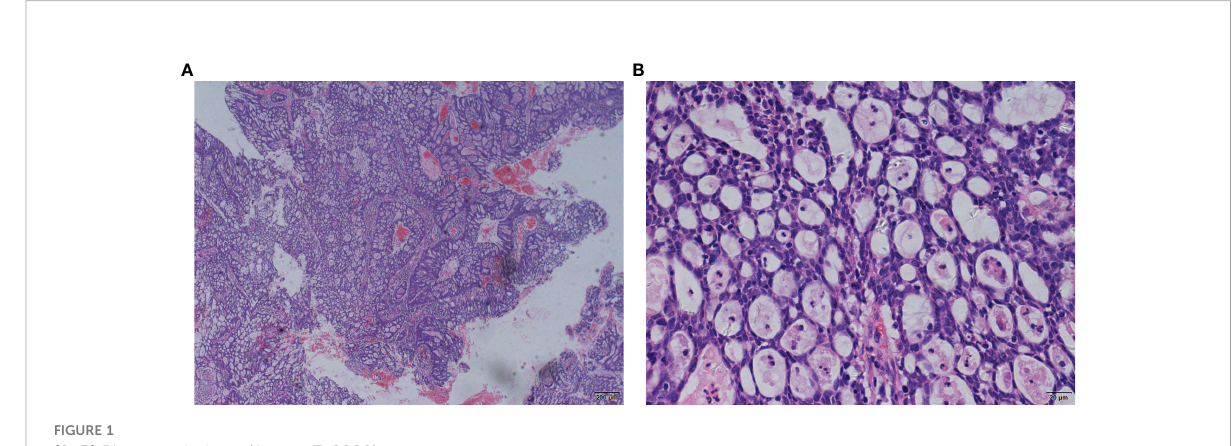
FIGURE 1 (A, B) Biopsy pathology. (August 7,